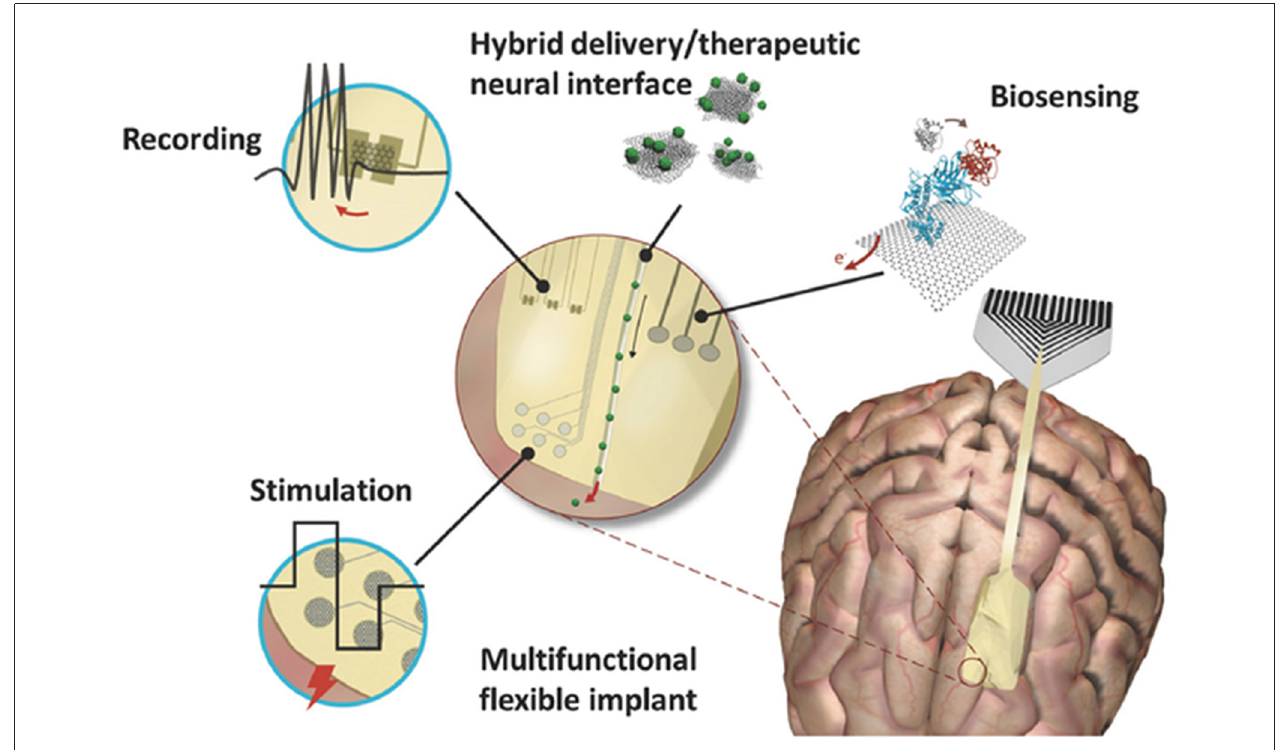
FIGURE 1 | Graphene based neural interfaces for a variety of neuronal functionalities like recording, stimulation and biosensing. Modified with permission from Kostarelos et al.